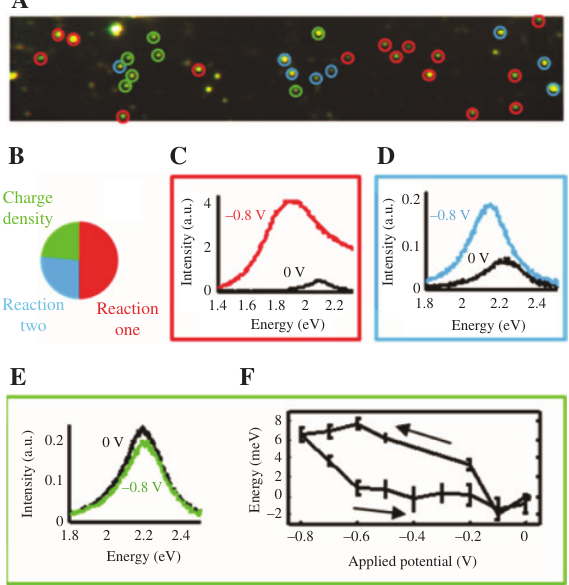
Figure 11: Heterogeneity observed during electrochemical tuning of individual AuNPs on ITO. (A) Hyperspectral dark-field image of AuNPs at open circuit potential. (B) Organization of AuNPs into three categories based on the behavior during potential scan with